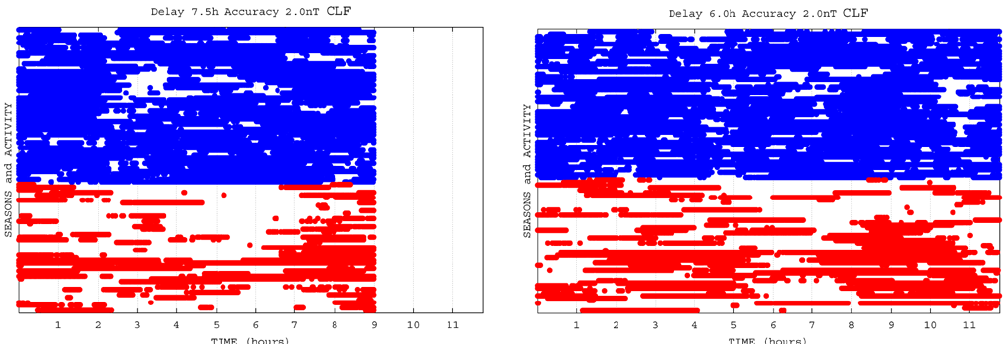
Fig. 8. Time table for CLF data. Same legend as for Fig.